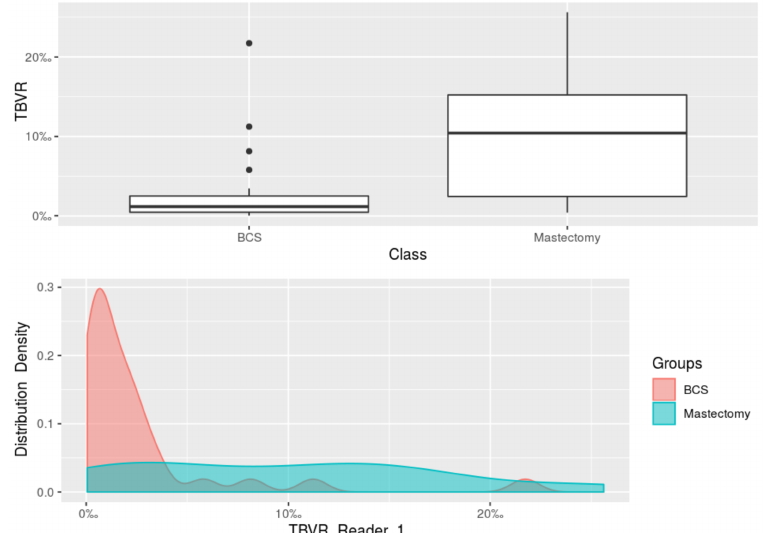
Figure 4. Boxplot and density plot for the comparison of the tumour-to-breast volume ratio obtained from Reader 1’s segmentations of MRI images of the women undergoing breast-conserving surgery and of the women undergoing mastectomy. BCS, breast-conserving surgery; TBVR, tumour-to-breast volume